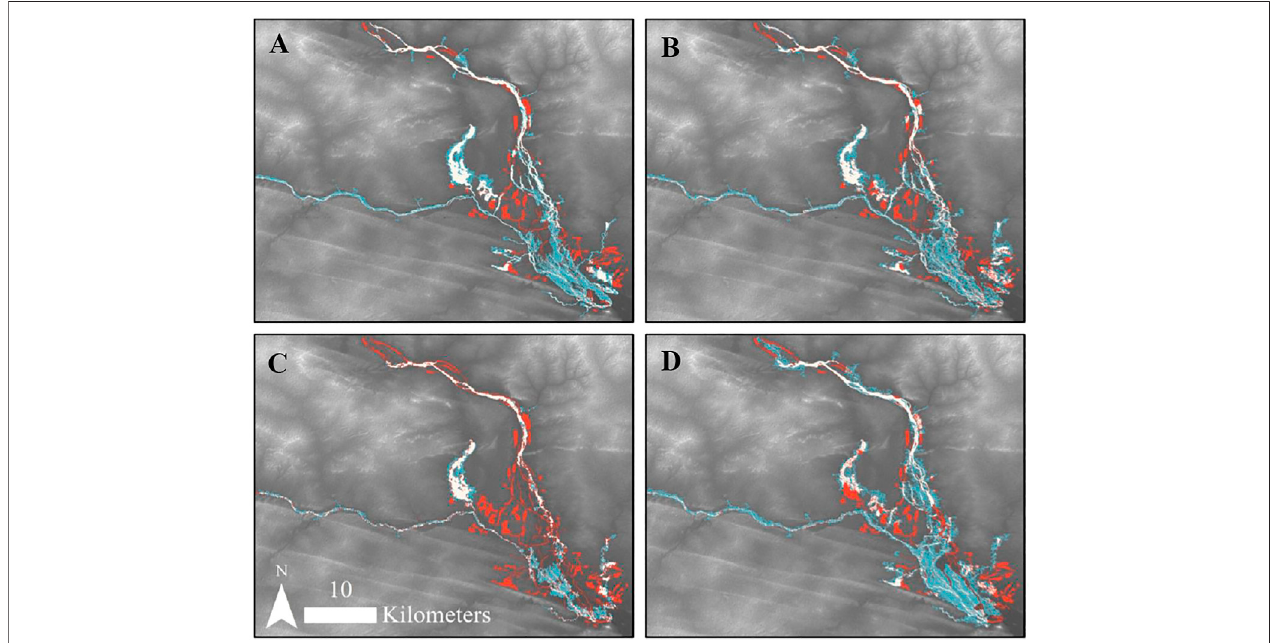
FIGURE 5 | Comparisons of AW3D30, SRTM, MERIT, and ASTER DEMs [ (A – D), respectively] derived fl ood extents to the LiDAR DEM derived fl ood extents from the HAND model where white is agreement, red is the LiDAR DEM, and blue is the global DEM.